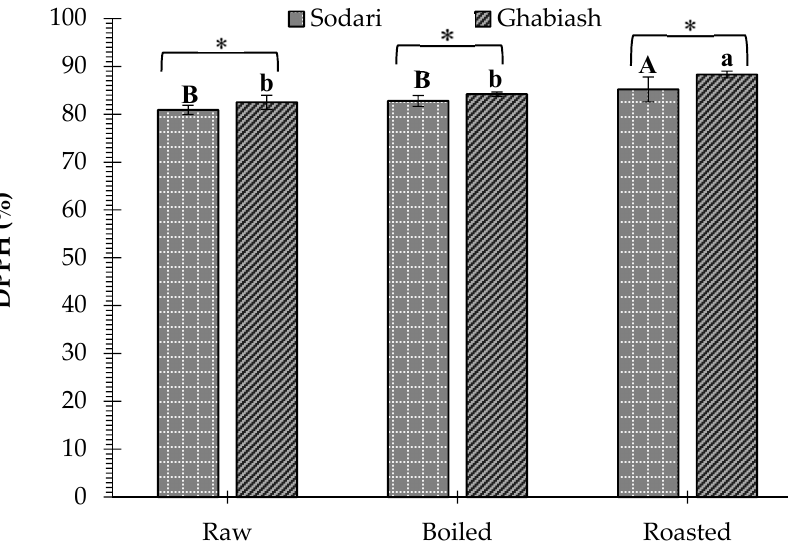
Figure 3. Effect of boiling and roasting on the DPPH scavenging activity (%) of peanut cultivar shells. Data represent mean ± SD ( n = 3). Values followed by the same letter are not significantly different ( p < 0.05) as evaluated by LSD. Capital letters indicate significant differences between raw and processed samples of Sodari cultivars, whereas lower case letters indicate significant differences between raw and processed samples of Ghabiash cultivar. * shows the significant differences between means of cultivars, while ns shows the insignificant differences between means of cultivars in the raw and processed samples.